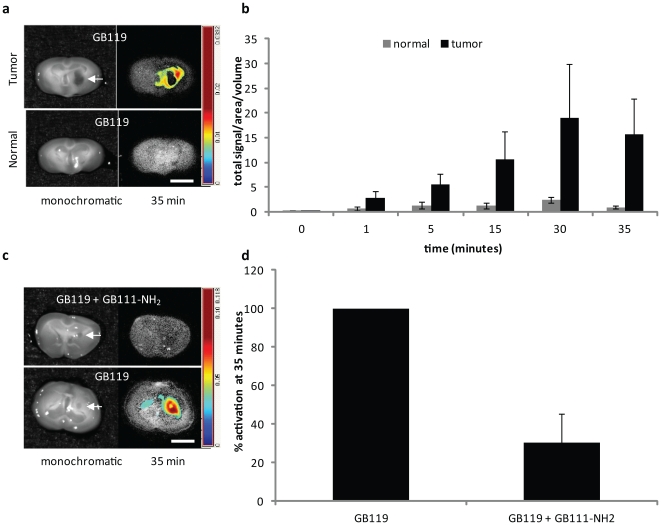

Ex vivo activation of GB119 in orthotopic brain tumors.(a) Representative 2-mm sections from normal and tumor-bearing brains (see arrow for main tumor mass). Monochromatic images are shown on left and unmixed false colored maps of pixel intensity representing activated GB119 at 35 minutes are shown on the right. (b) The averages of total signal/area/volume from the slices for each animal is plotted over time for normal (n = 3) and tumor (n = 6) groups. The groups did not differ at time 0 (p = 0.65). Using Bonferroni correction with overall significance level 0.05, the groups differed significantly at times 5, 15, 30 and 35 minutes. (c) Inhibition of GB119 activation in an orthotopic brain tumor model using opposing brain slices (opened like a book) containing tumor (arrow, n = 11). (d) Percent inhibition of GB119 activity was determined for each mouse and is presented as mean +/− standard deviation at 35 minutes. Using Bonferroni correction for multiple testing at times the groups did not differ at time 0 (p = 0.86) but differed significantly at times 1, 15, 30 and 35 minutes (p<0.0003). Scale bar, 5 mm.